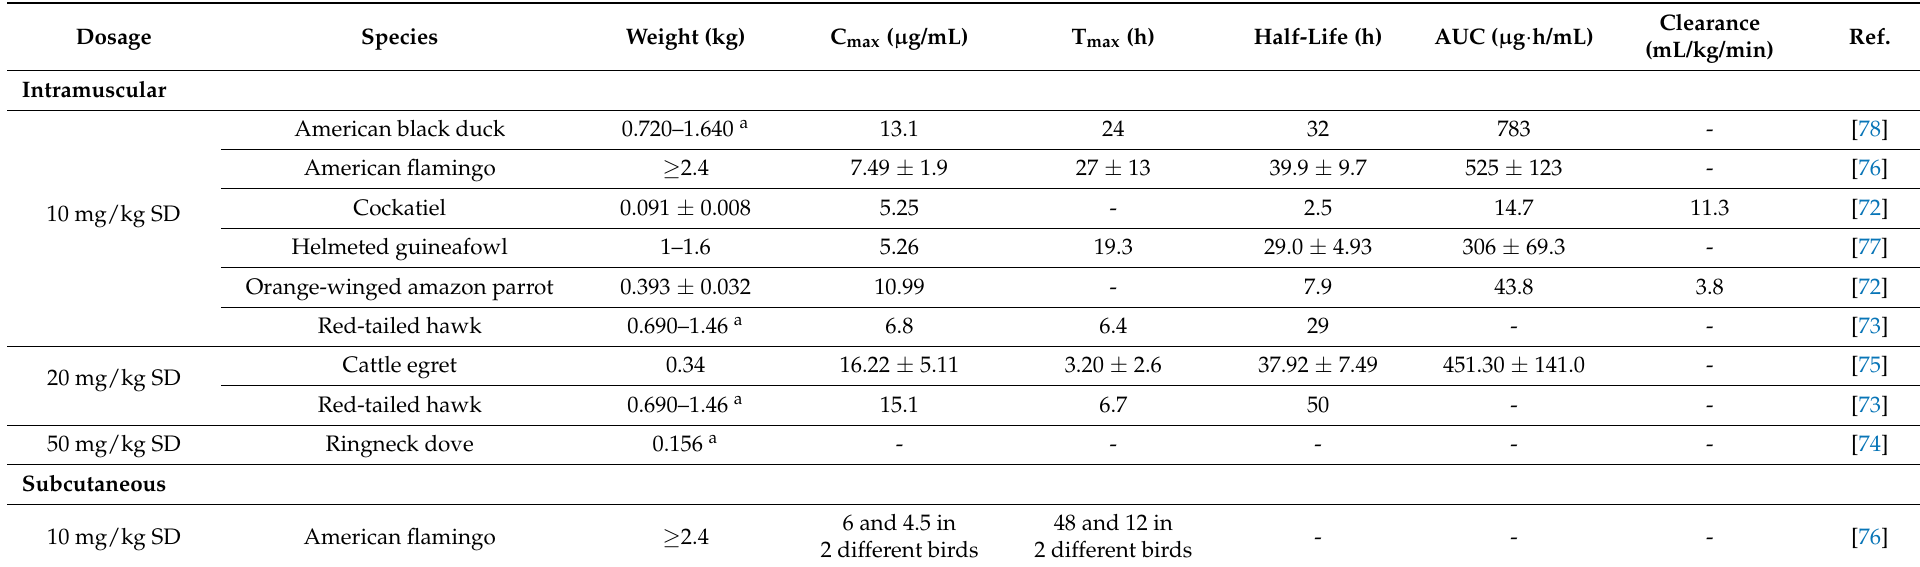
Table 11. Pharmacokinetic values for ceftiofur in exotic avian